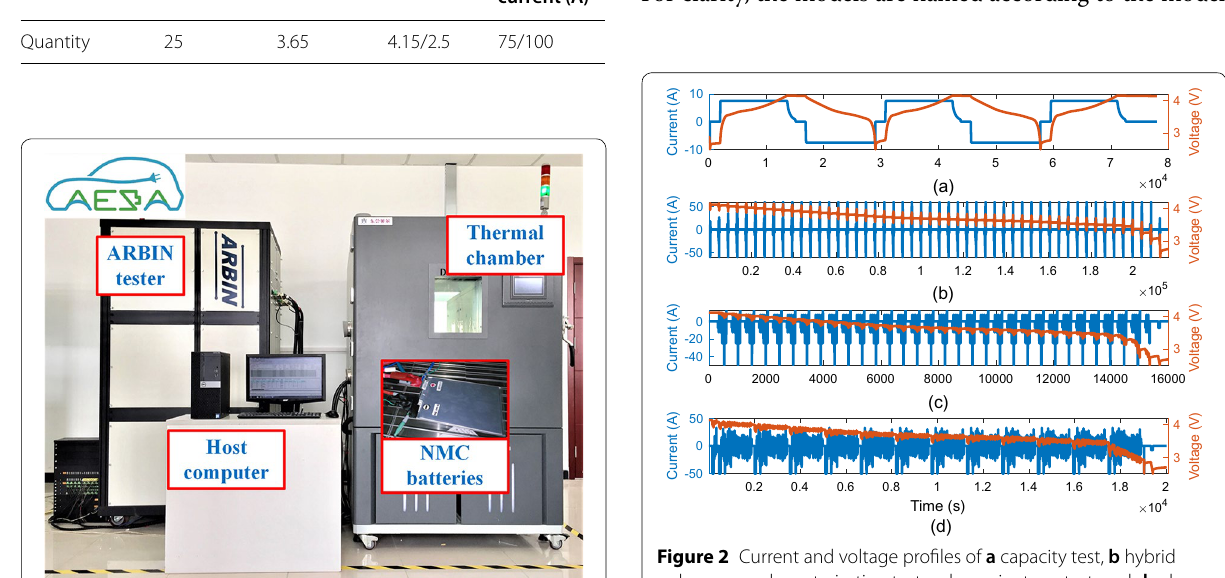
Figure 1 Battery test platform